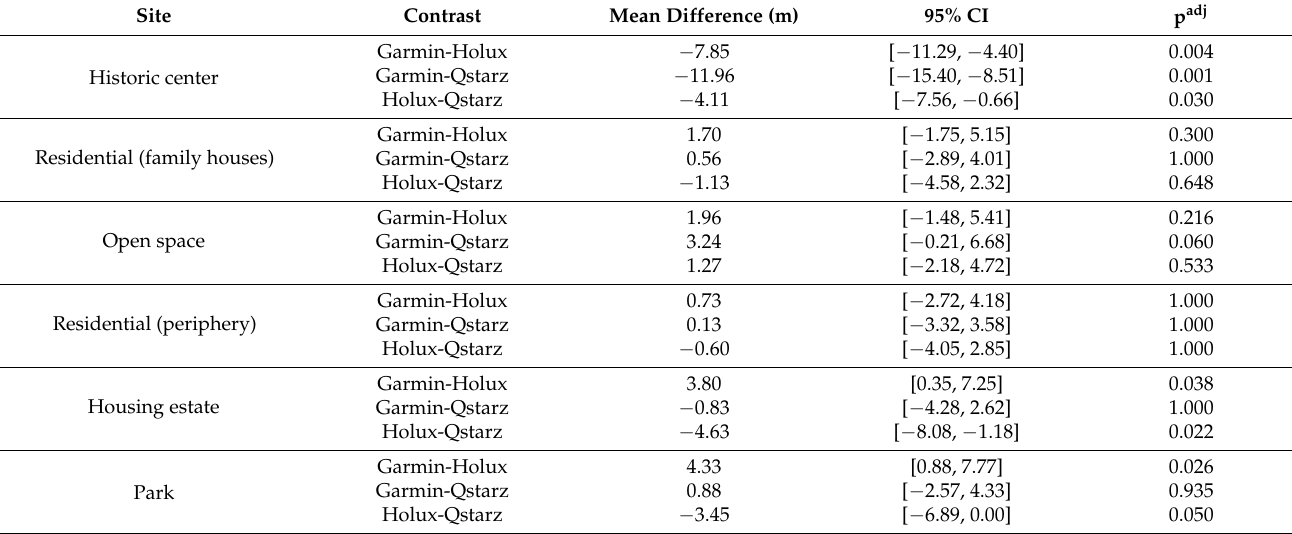
Table 3. Pairwise contrasts between devices across the six